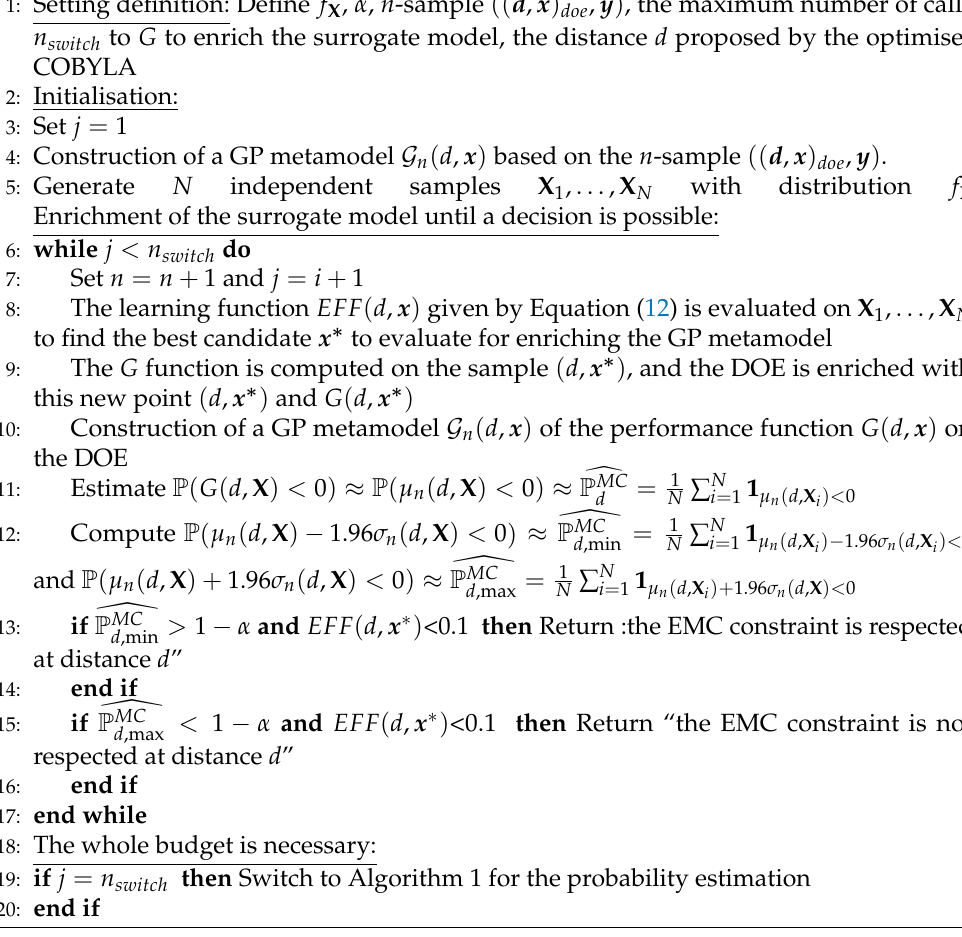
Algorithm A2 EMC probability evaluation with the surrogate